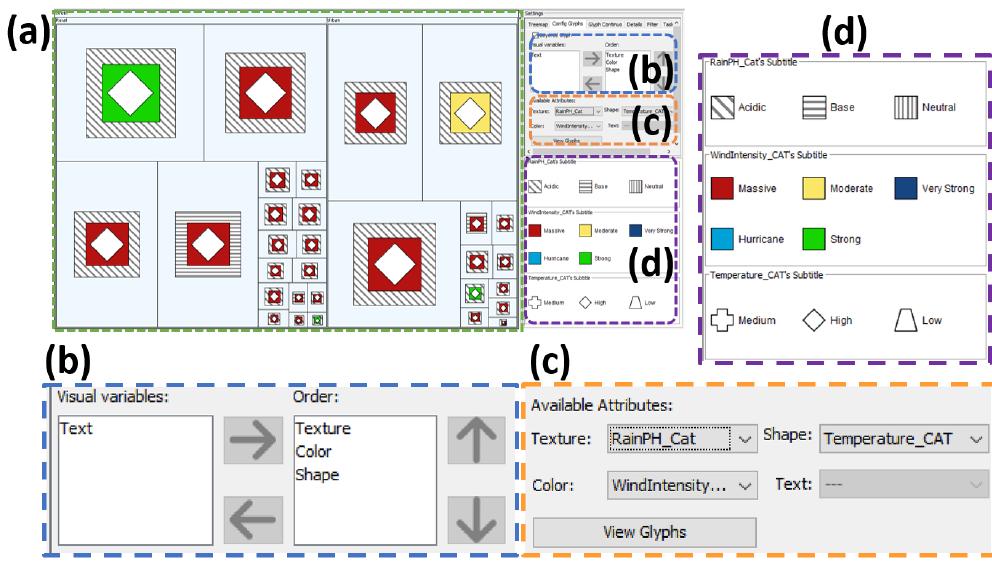
Figure 6. ( a )—Overview of the prototype composed by Treemap and glyphs; ( b )—Glyph’s visual variables configuration area; ( c )—Visual variables mapping area of the attributes; ( d )—Presentation area of the glyph’s